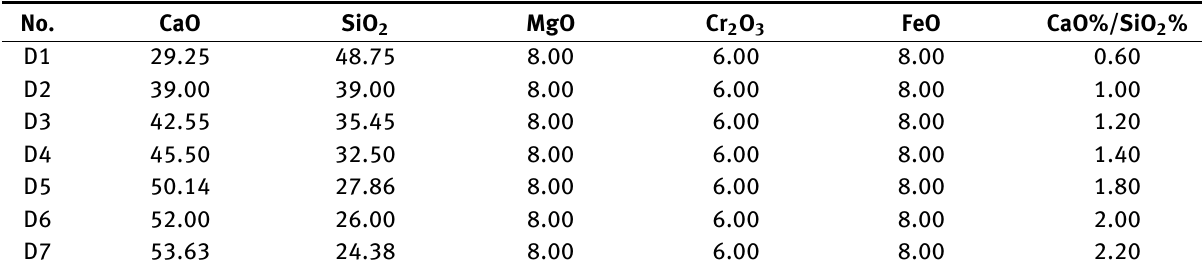
Table 1: Chemical composition of the samples, g.